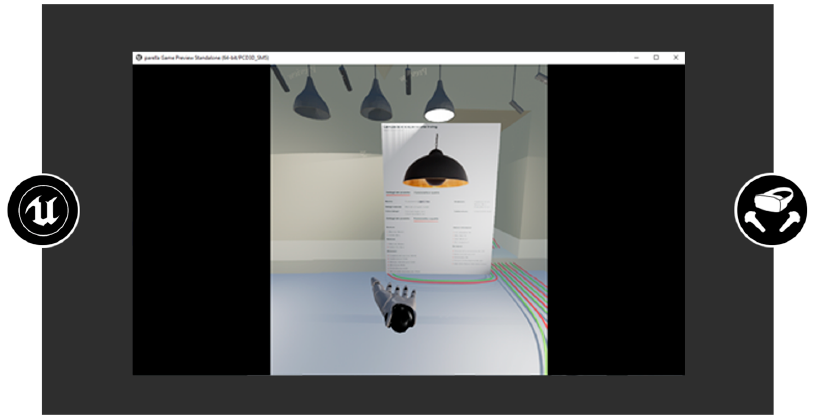
Figure 5. Lamp properties visualization with HTC Vive.